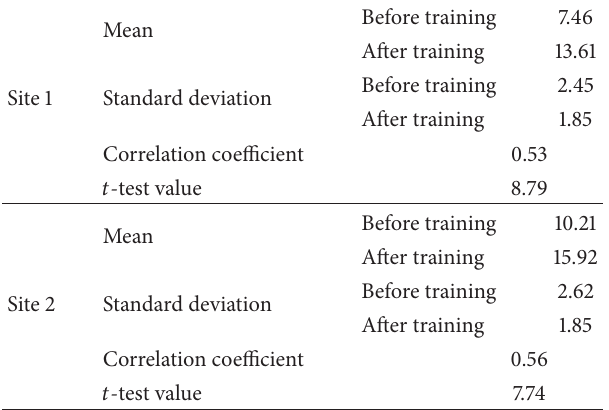
Figure 2: Graph showing effectiveness of the program at site